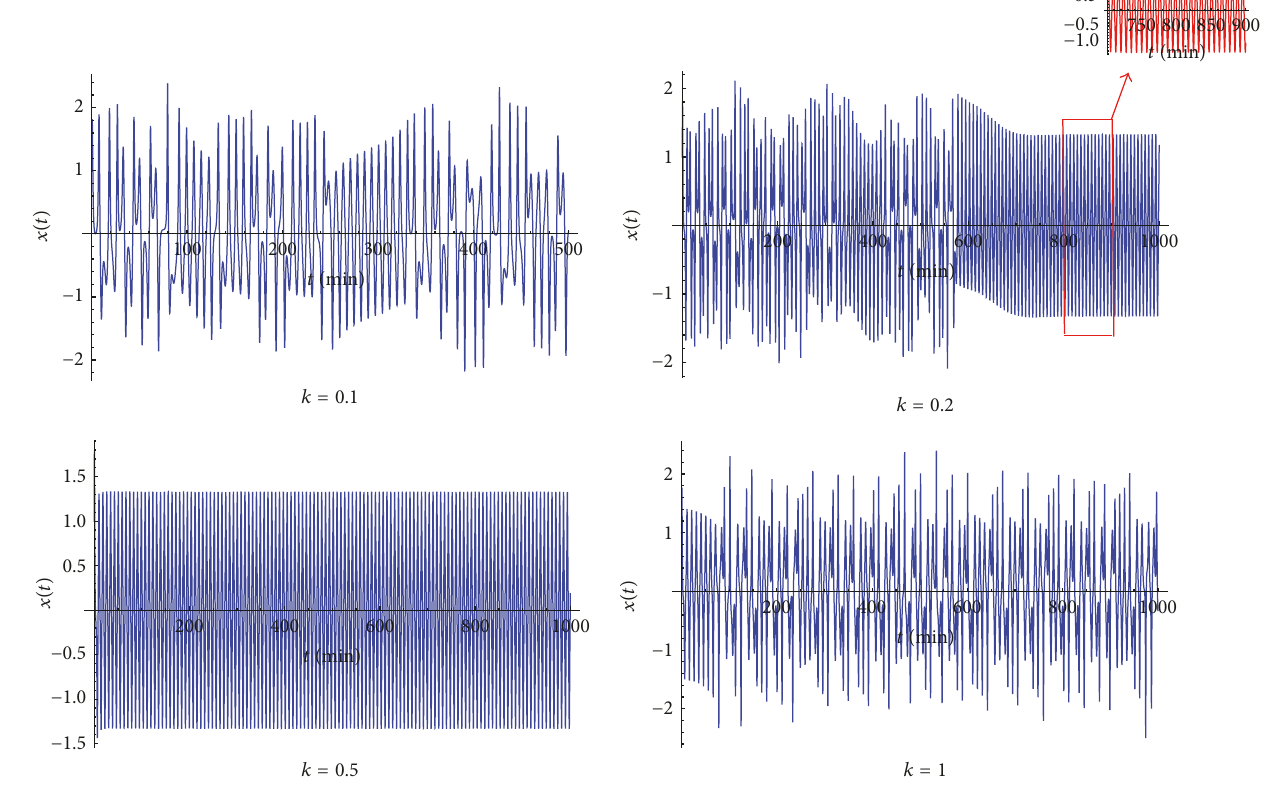
Figure 2: Time course of the system (1) with several fixed 𝑘